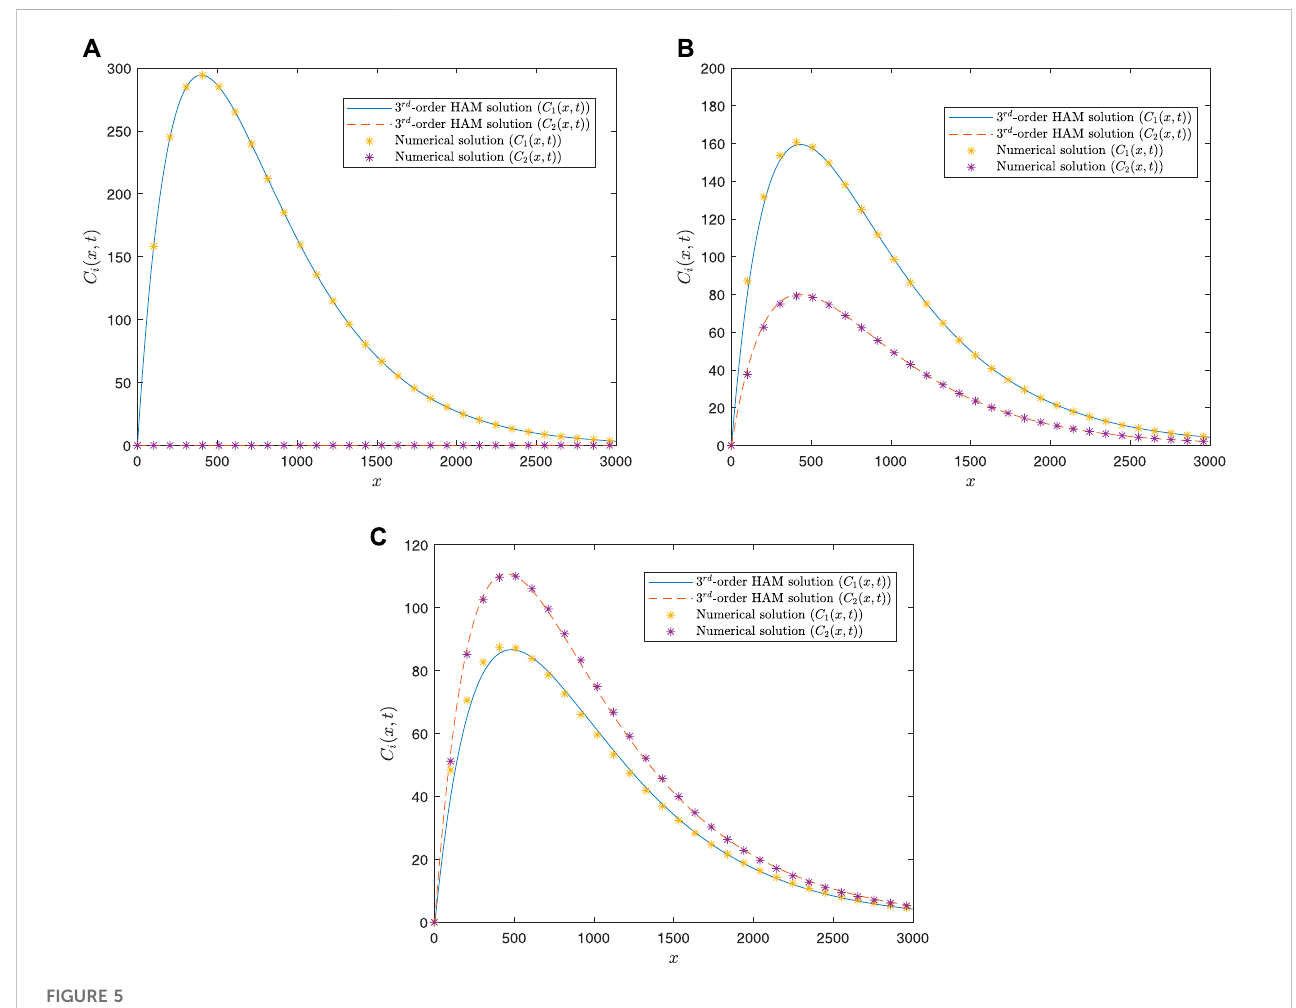
HAM-based pollutant concentrations versus distance for both species at: (A) t (cid:2) 0 h, (B) t (cid:2) 20 h, and (C) t (cid:2) 40